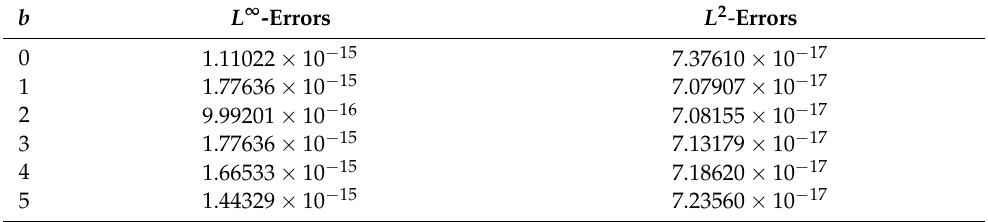
Figure 5. MAE of Z N ( x ) of our algorithm at υ 1 = 0.8 and b = 1 with N = 2 for Example 2. Table 5. Comparison of L ∞ - and L 2 -errors of our algorithm at υ 1 = 0.5 and N = 15 with distinct b for Example 3.